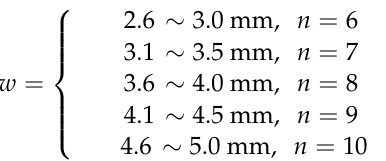
Figure 10. The relationship between the crack width and the number of pixels occupied. Therefore, in the flat interval, the index of the number of pixels occupied by the cracks can roughly judge the crack width range. The specific Equation (16) is shown below.